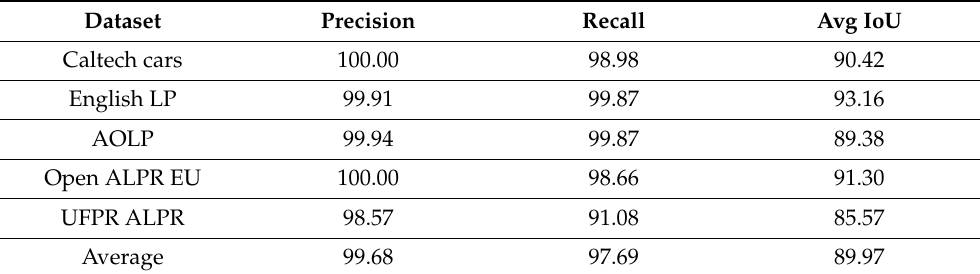
Table 7. LP detection results (%) in all five datasets.